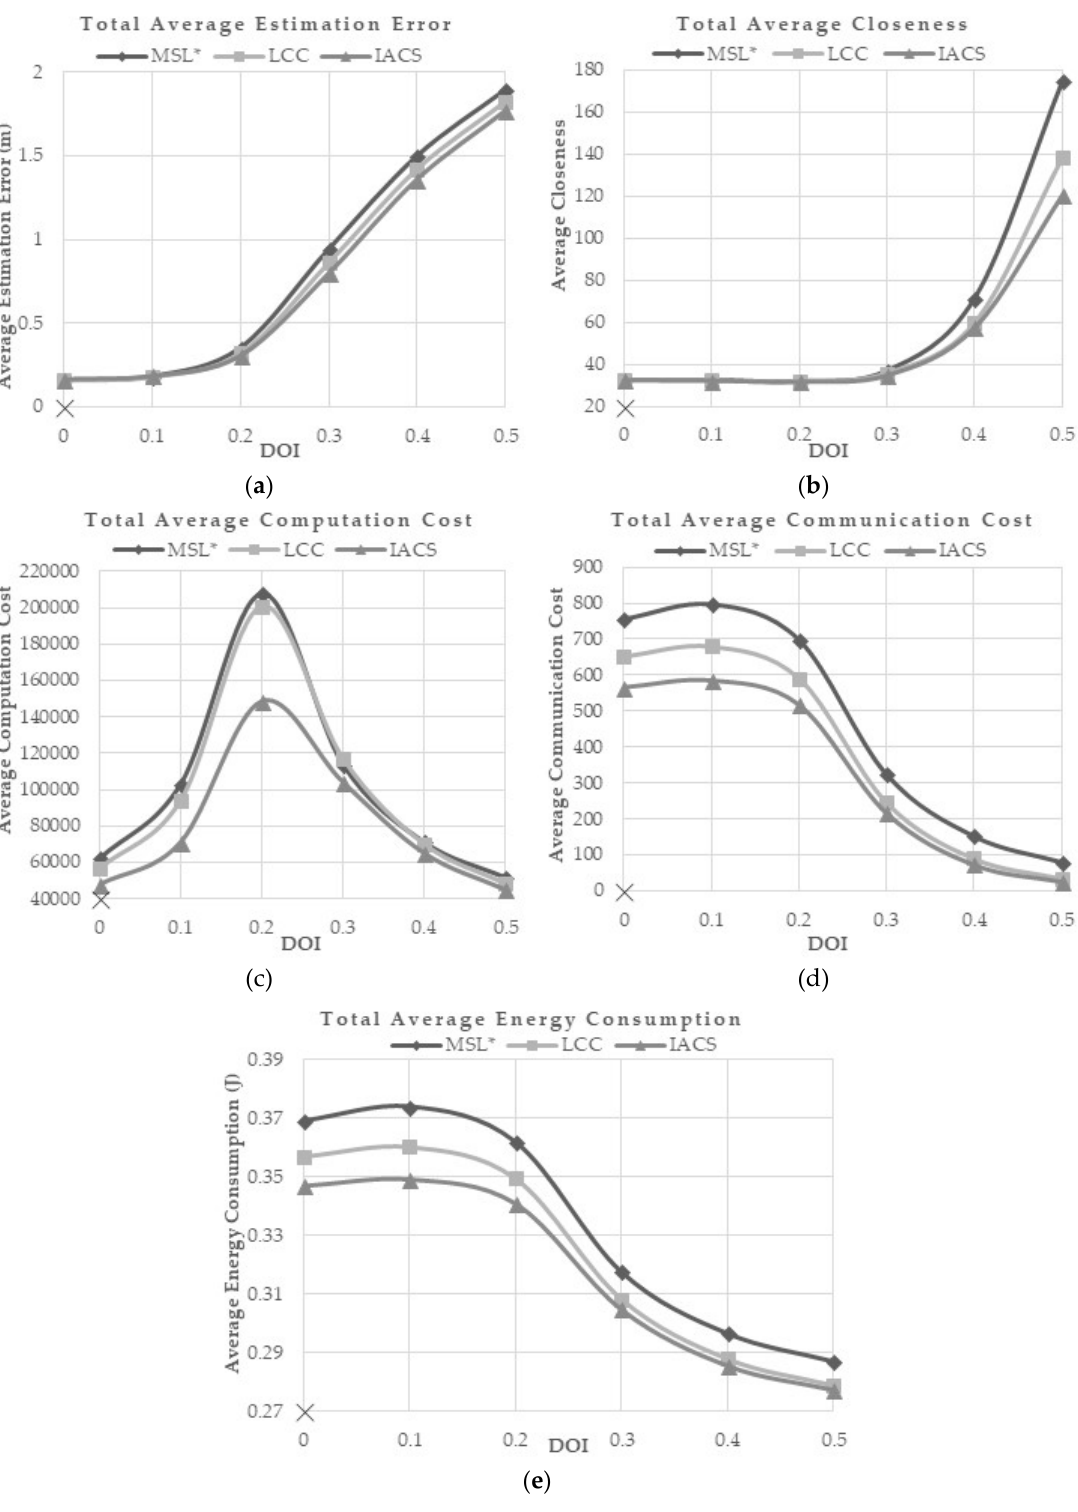
Figure 9. ( a ) Total Average Estimation Error, ( b ) Total Average Closeness, ( c ) Total Average Computation Cost, ( d ) Total Average Communication Cost, and ( e ) Total Average Energy Consumption for Different DOI.